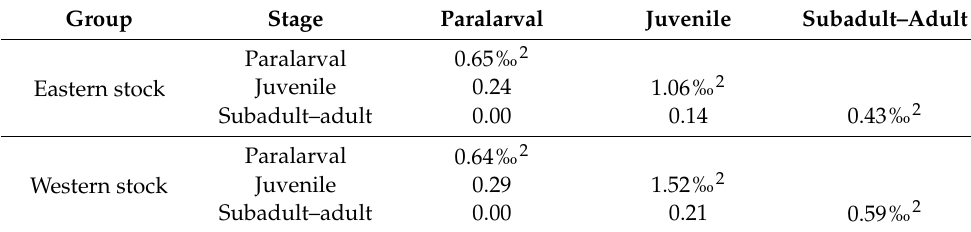
Figure 7. The standard ellipse area corrected (SEAc) for the squid eye lenses at different stages of development. Table 5. Eastern and western stock trophic SEAc (‰ 2 ) and overlap in different growth stages.